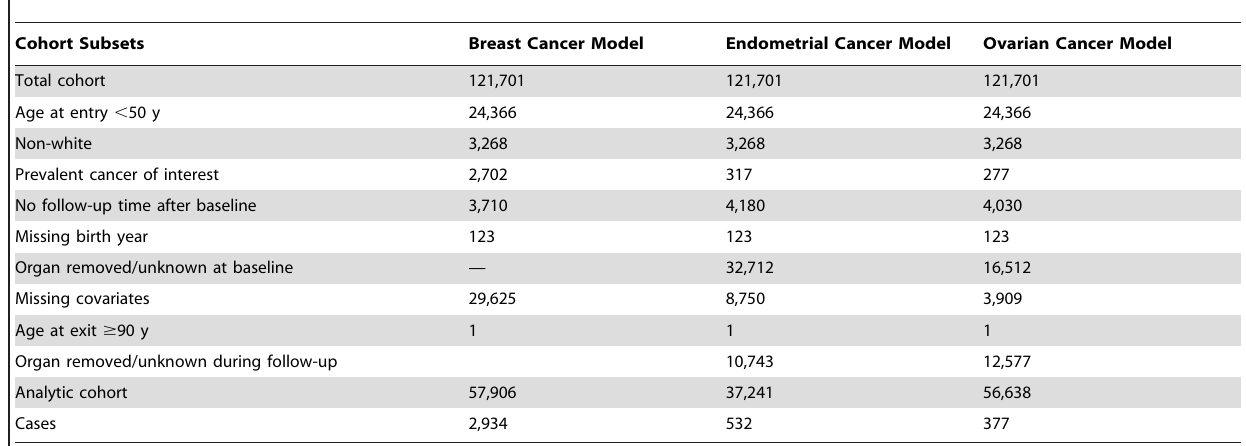
Table 2. Study population and exclusions for model validation: NHS cohort at baseline.